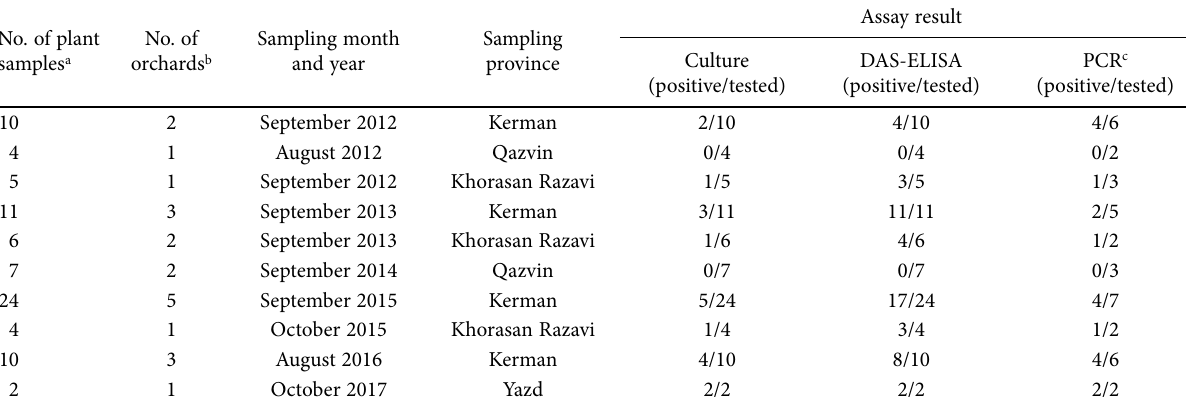
Table 1. Results of orchard survey for Xylella fastidiosa in symptomatic pistachio plant samples from Iran.